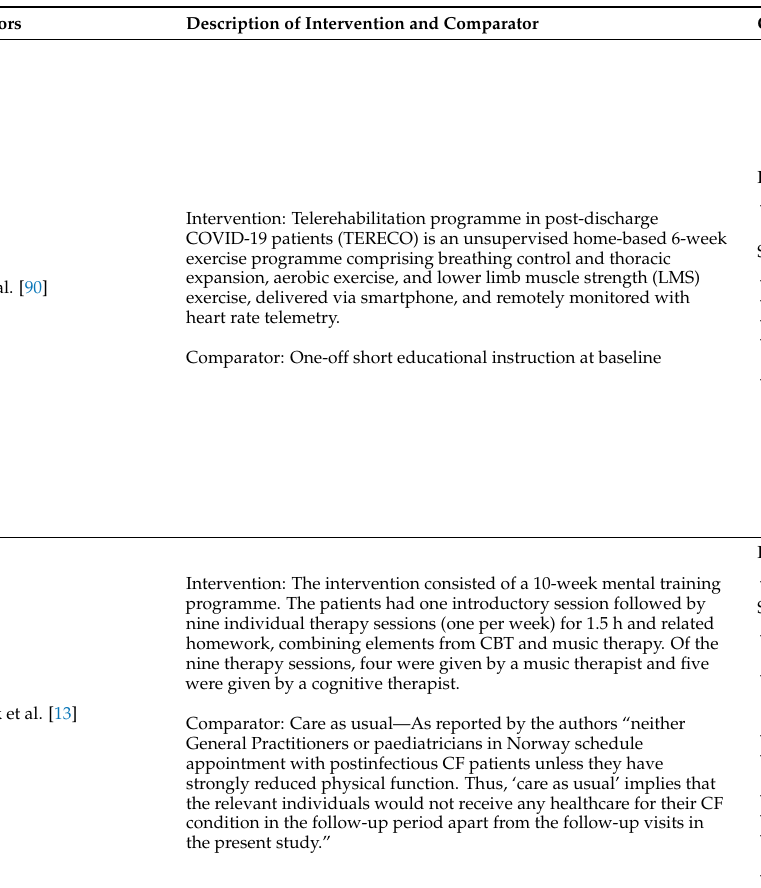
Table 2. Intervention design, outcome measures and key findings of